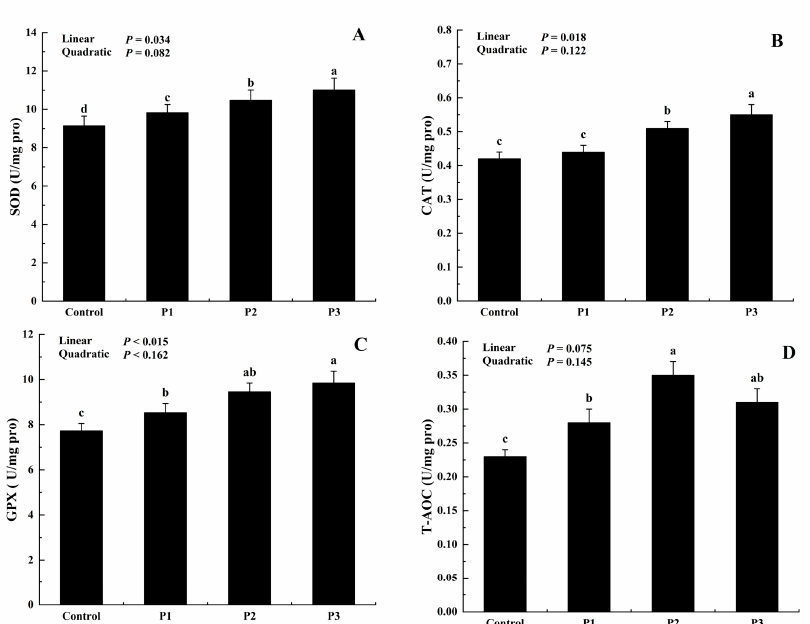
Figure 4. Effect of dietary dried jujube fruit powder (DJFP) supplementation on the antioxidant enzyme activity of the broilers. ( A ) Effect of dietary DJFP supplementation on the SOD. ( B ) Effect of dietary DJFP supplementation on the CAT of the broilers. ( C ) Effect of dietary DJFP supplementation on GPX of the broilers. ( D ) Effect of dietary DJFP supplementation on the T-AOC of the broilers. Control, P1, P2, and P3 diets contained 0, 50, 100, and 150 g/kg of DJFP in the diet, respectively. a–d Values with different letters above the column mean significant difference ( p < 0.05).